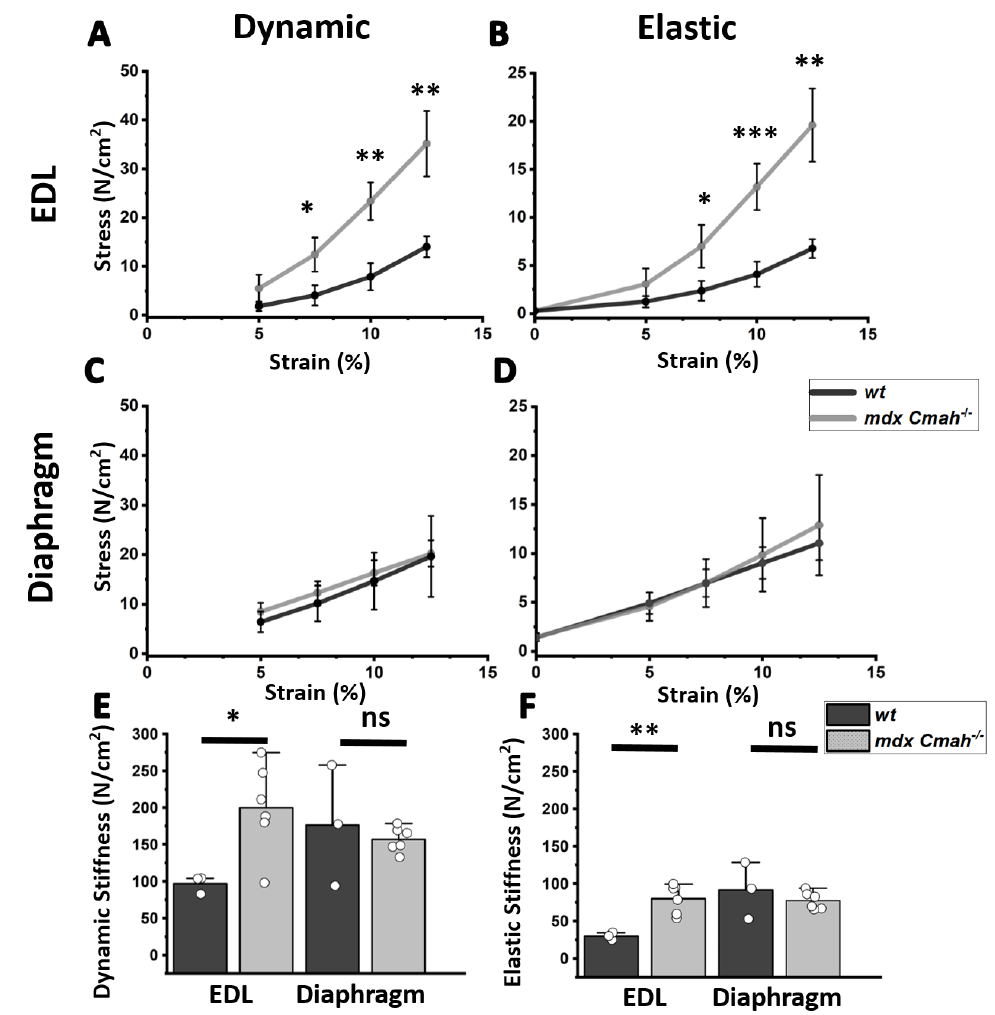
Figure 3. Passive visco-elastic stiffness is markedly increased in mdx Cmah − / − EDL but not in di- aphragm muscles. Passive stresses (i.e., specific forces) of whole EDL (top panels, A , B ) and diaphragm strips (central panels, C , D ) from age-matched wt (n = 3) and mdx Cmah − / − mice (n = 6). EDL muscles from mdx Cmah − / − mice present with significantly higher stress values for the same strain. This results in increased dynamic and elastic stiffness in the EDL muscles but not the diaphragm muscles ( E , F ). Data are means ± SD. *, p < 0.1, **, p < 0.01, ***, p < 0.001 for comparisons between wt and mdx Cmah − / − muscles. ns, not